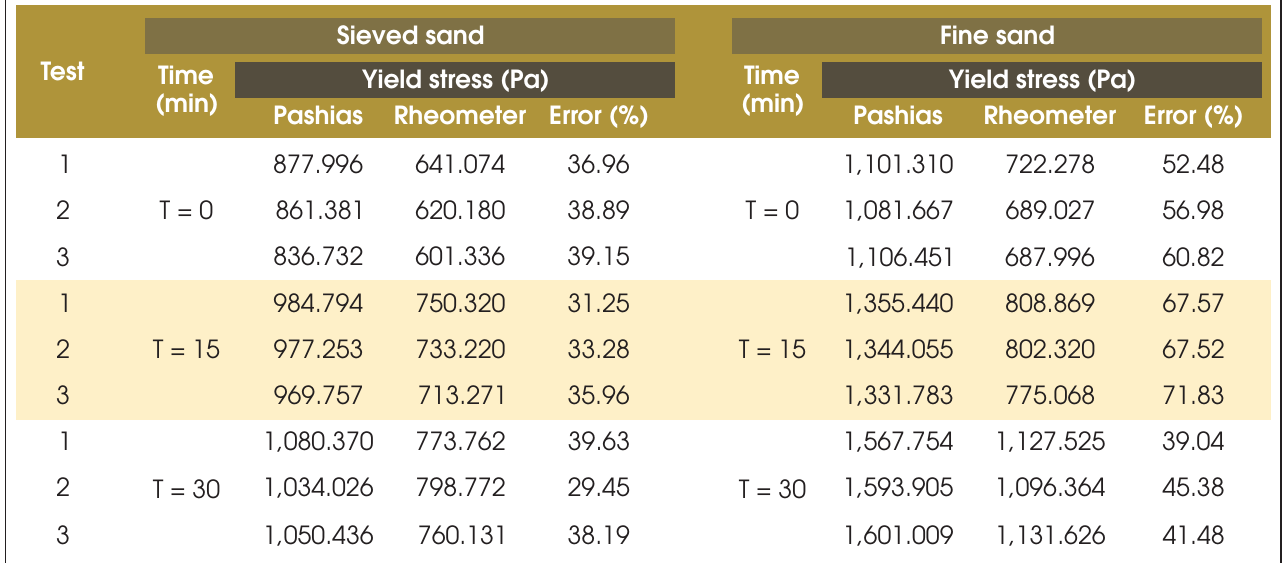
Table 8 – Comparison of yield stress calculated by the method of Pashias and by classical rheometry with their respective errors for mortars with w/c ratio = 0.40